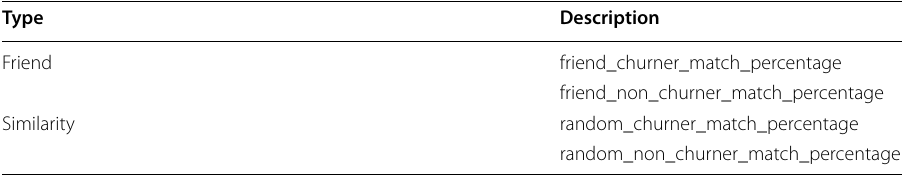
Table 2 The network features that are divided into two types: Friend and Similarity, originating from the friend and similarity networks,